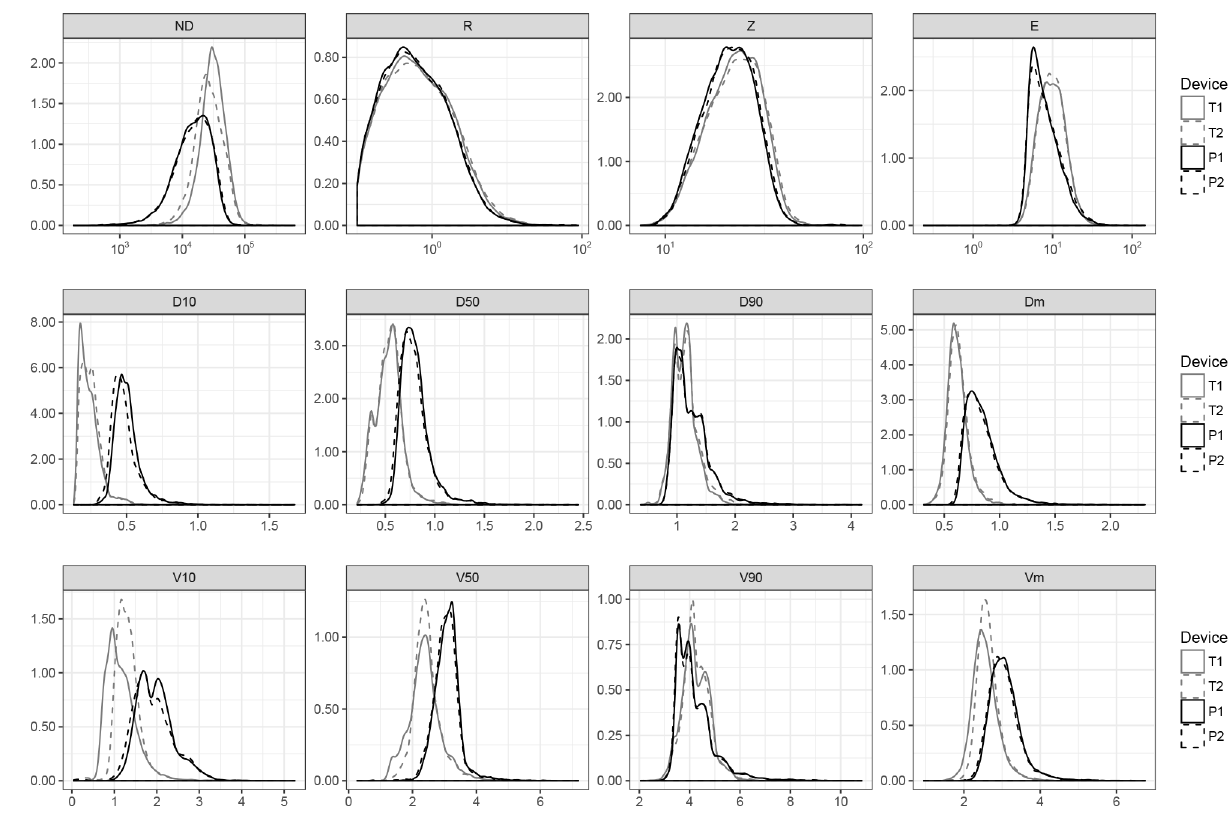
Figure A3. Kernel density plots for 1min records, with no corrections of the PSVD